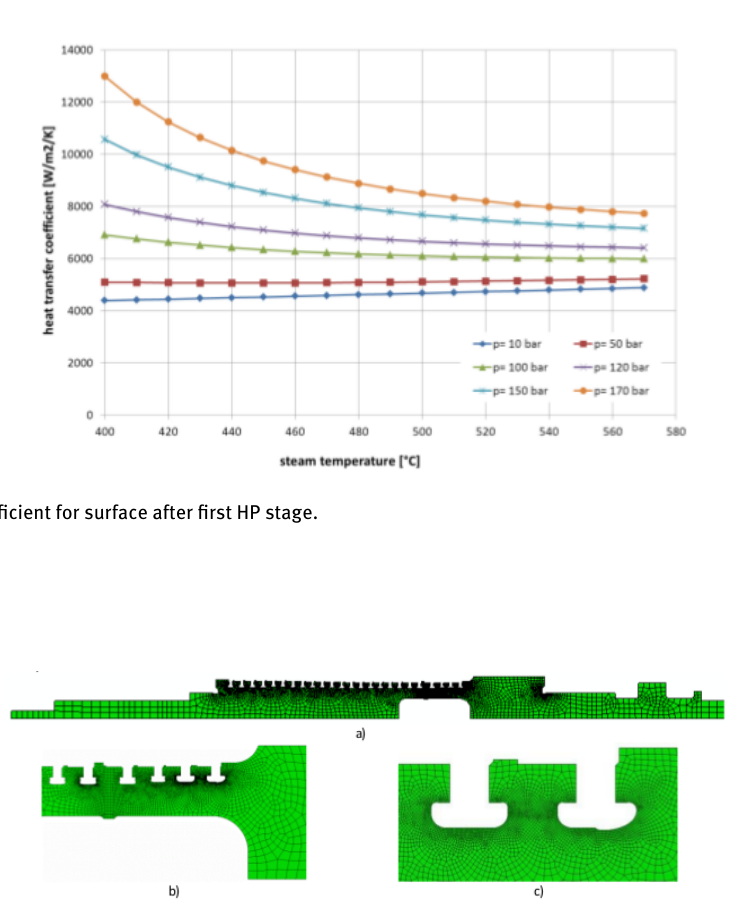
Figure 6: FE model of 18K390 turbine HP rotor: a) whole model, b) steam inlet view, c) 1st and 2nd blade grooves.